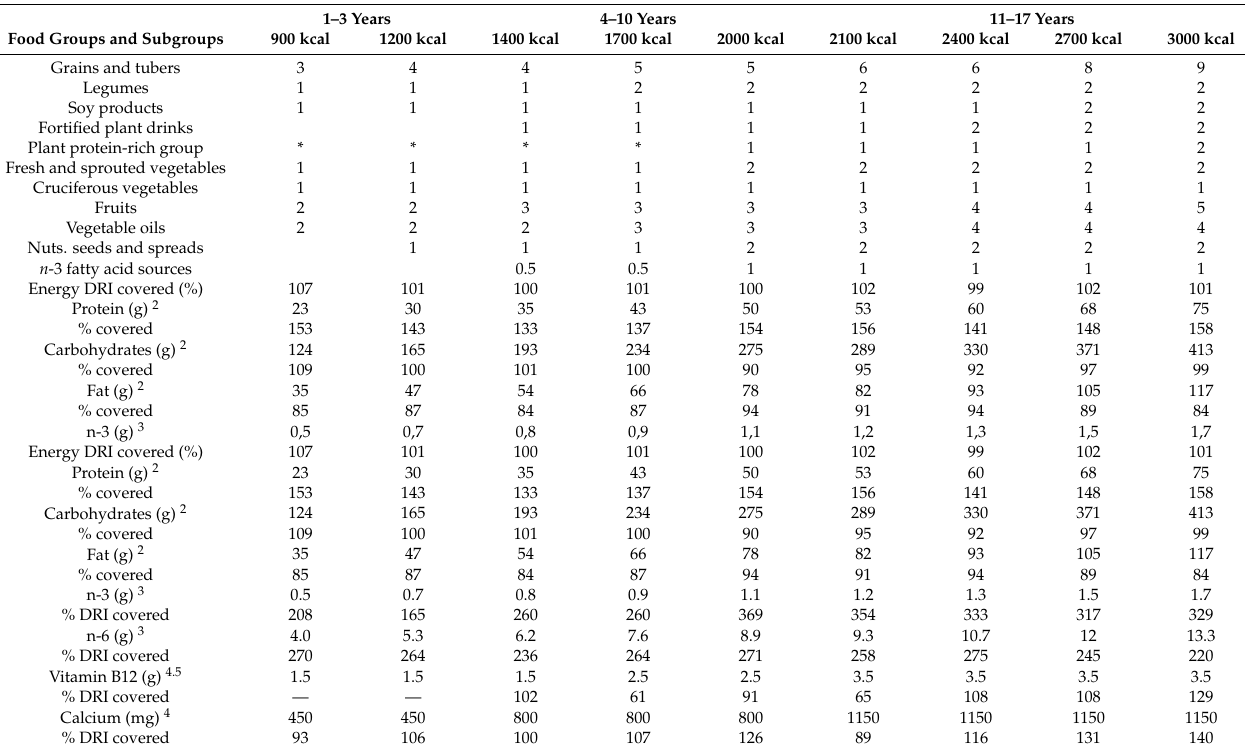
Table 2. Suggested number of portions of each group and subgroup for vegan children and adolescents considering nutritional requirements and physical activity levels (from sedentary to moderately active 1